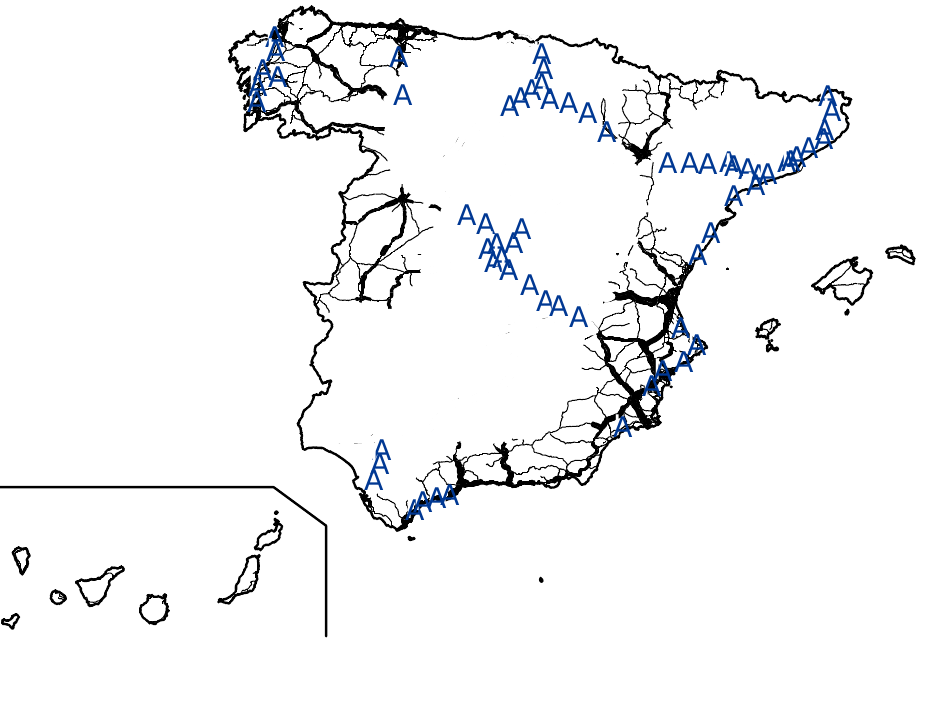
Figure 1. Demand remaining uncovered and 66 possible